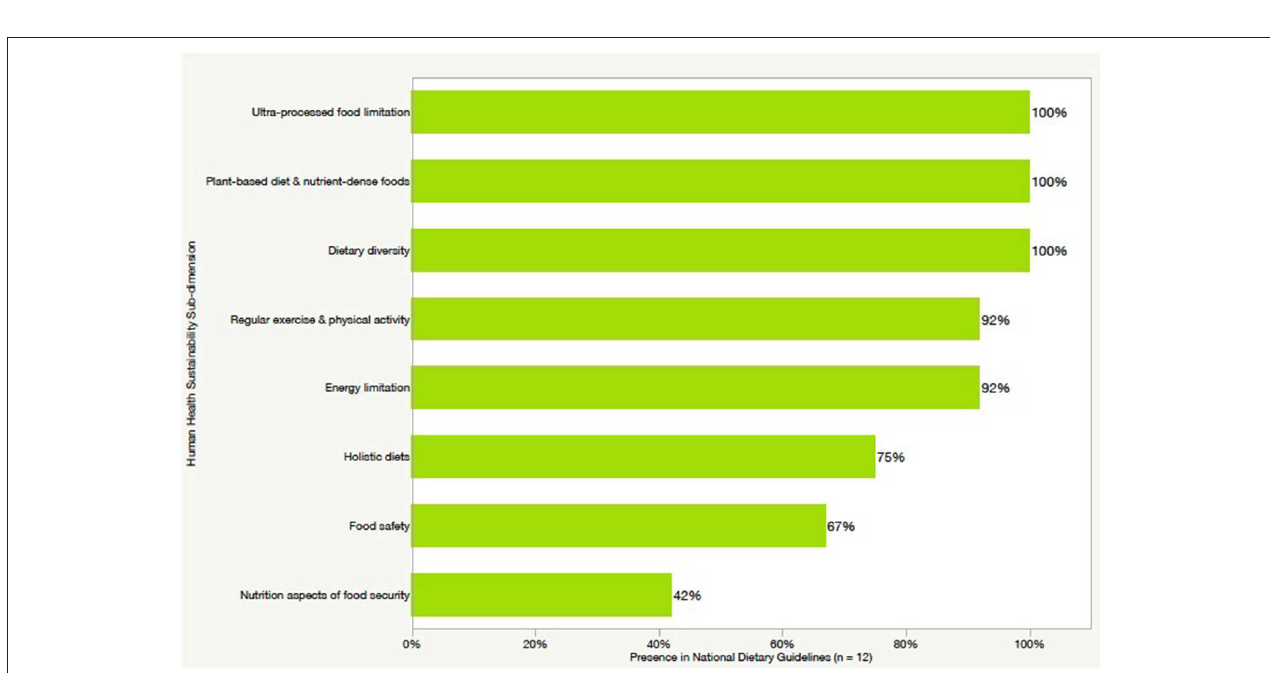
that is directly linked to health disparities among vulnerable populations including the lowest income and marginalized groups (Alesina and Glaeser, 2004). Ultimately, taking an